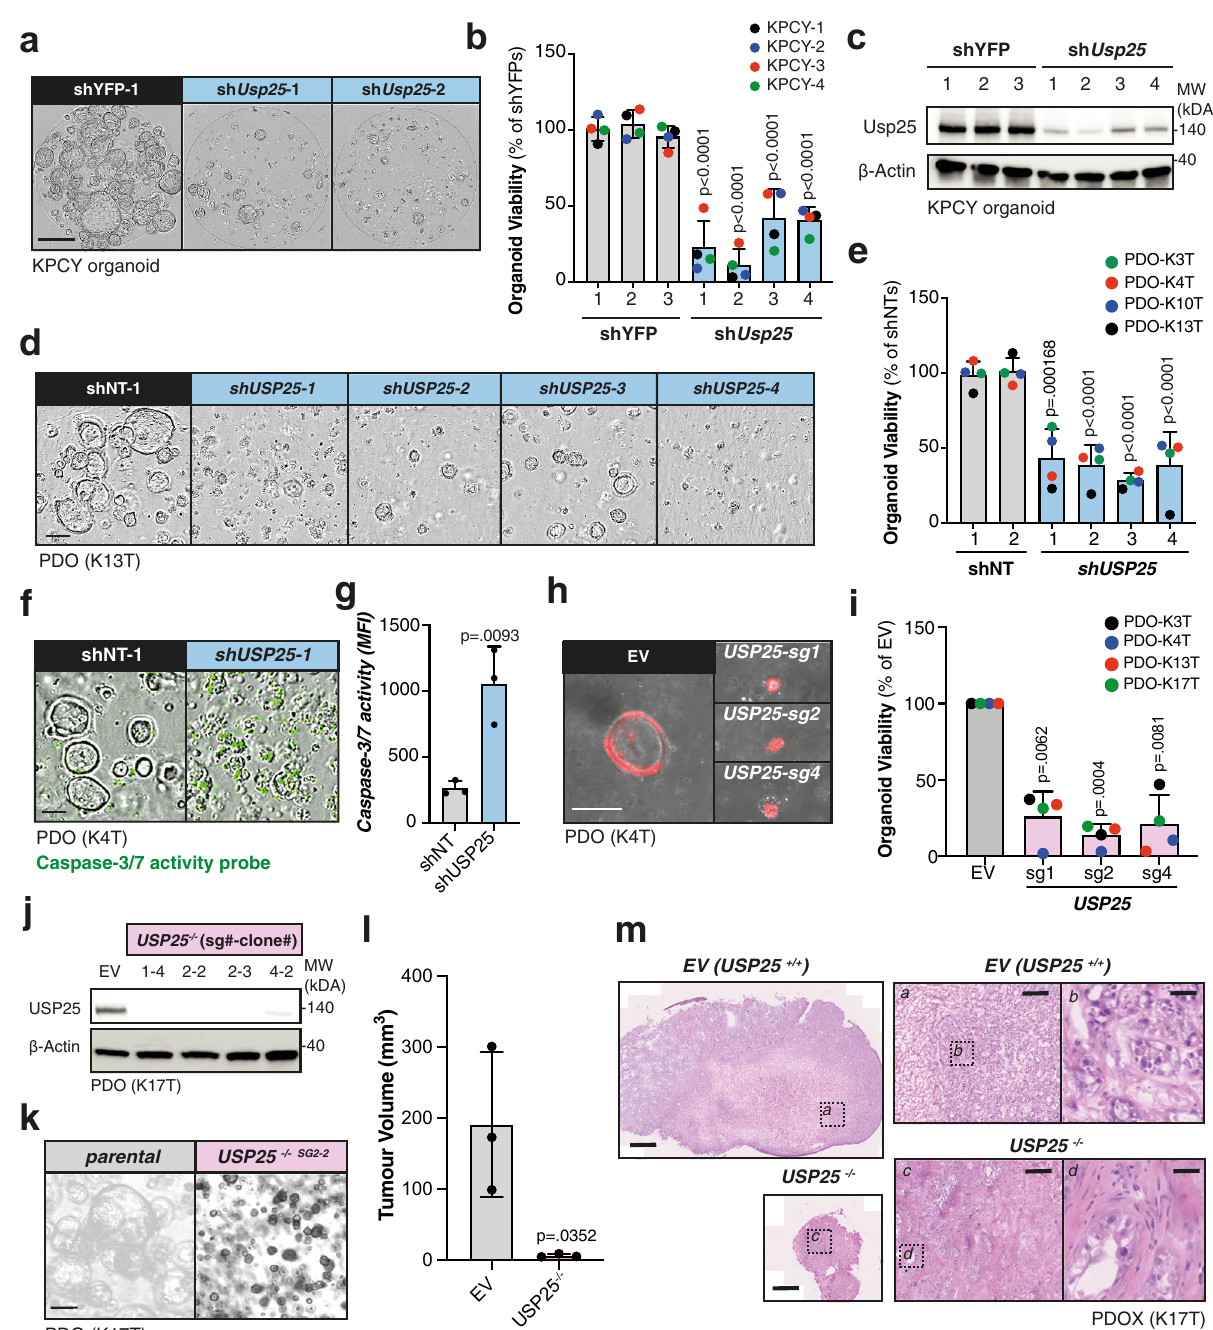
Fig. 4 Depletion of USP25 leads to reduced patient-derived organoid formation, viability and attenuated PDAC tumor growth in vivo. a Representative images of sh Usp25 silencing in KPCY organoids. Scale bar is 800 µ m. b KPCY organoid viability displayed as % relative to shYFP controls ( n = 4